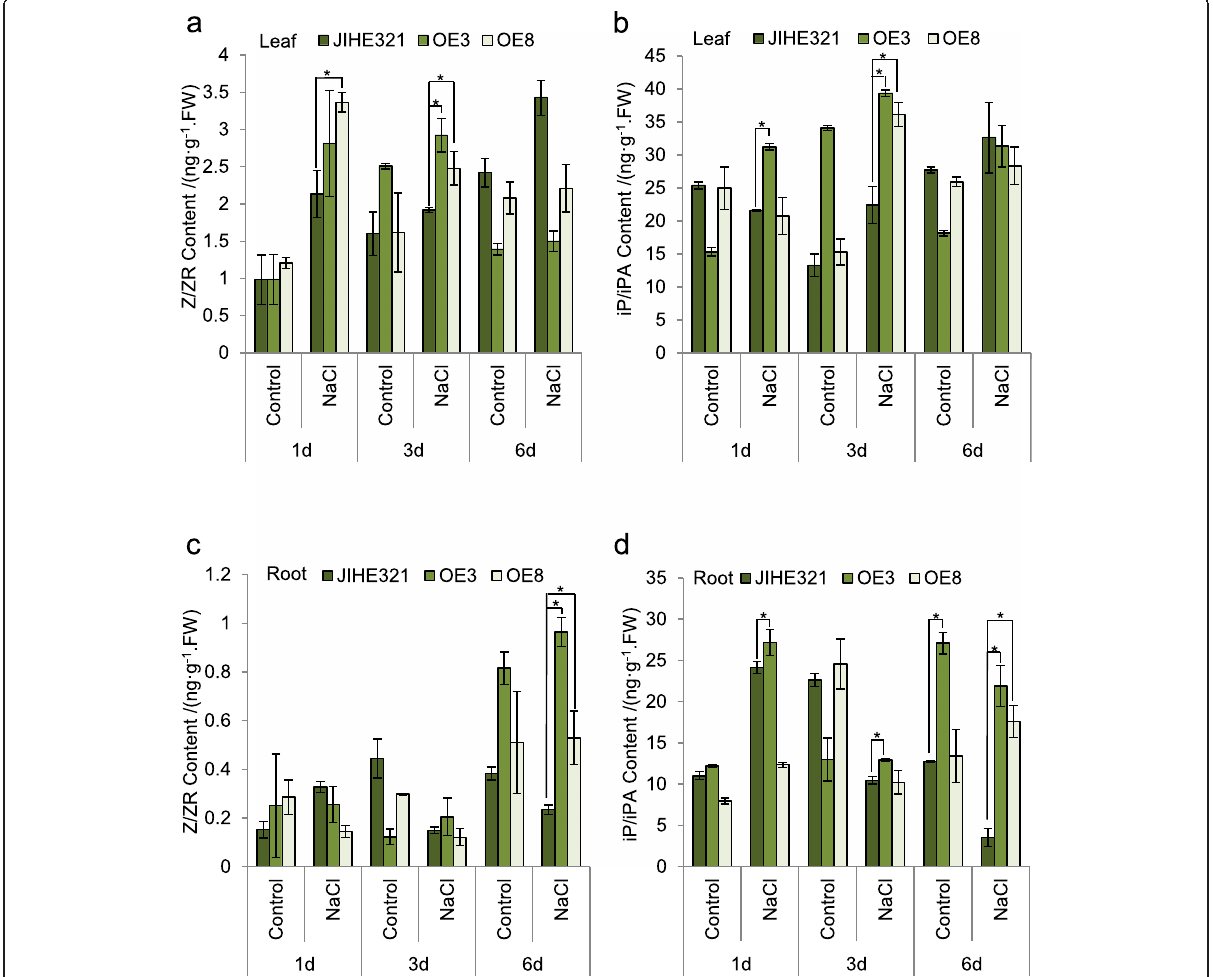
Fig. 4 Ectopic-expression of SAG12::IPT induces cytokinin content both in leaves and roots. a Ectopic expression of SAG12::IPT induces Z/ZR-type cytokinin content in the third true leaf of OE3 and OE8. The third true leaf (0.5 g) of transgenic lines and control cotton were collected after one, three and six days 220 mmol·L − 1 NaCl treatment to detect Z/ZR-type cytokinin content. b Ectopic expression of SAG12::IPT induces iP/iPA-type cytokinin content in the third true leaf of OE3 and OE8. The samples were collected as ( a ). c Ectopic expression of SAG12::IPT induces Z/ZR-type cytokinin content in roots of OE3 and OE8. The root samples (0.5 g) of transgenic lines and control cotton were collected after one, three and six days 220 mmol·L − 1 NaCl treatment to detect Z/ZR-type cytokinin content. d Ectopic expression of SAG12::IPT induces iP/iPA-type cytokinin content in roots of OE3 and OE8. The samples were collected as ( c ). The data are shown as means ± SD from three repeats ( n = 3, * P ≤